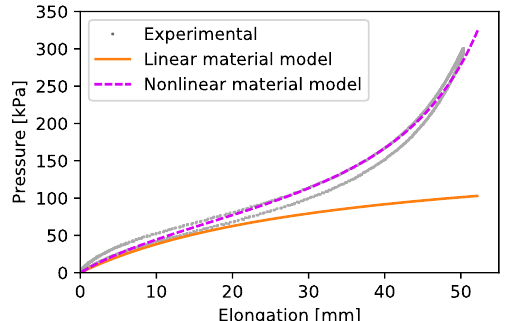
Figure 11. Relationship between elongation and